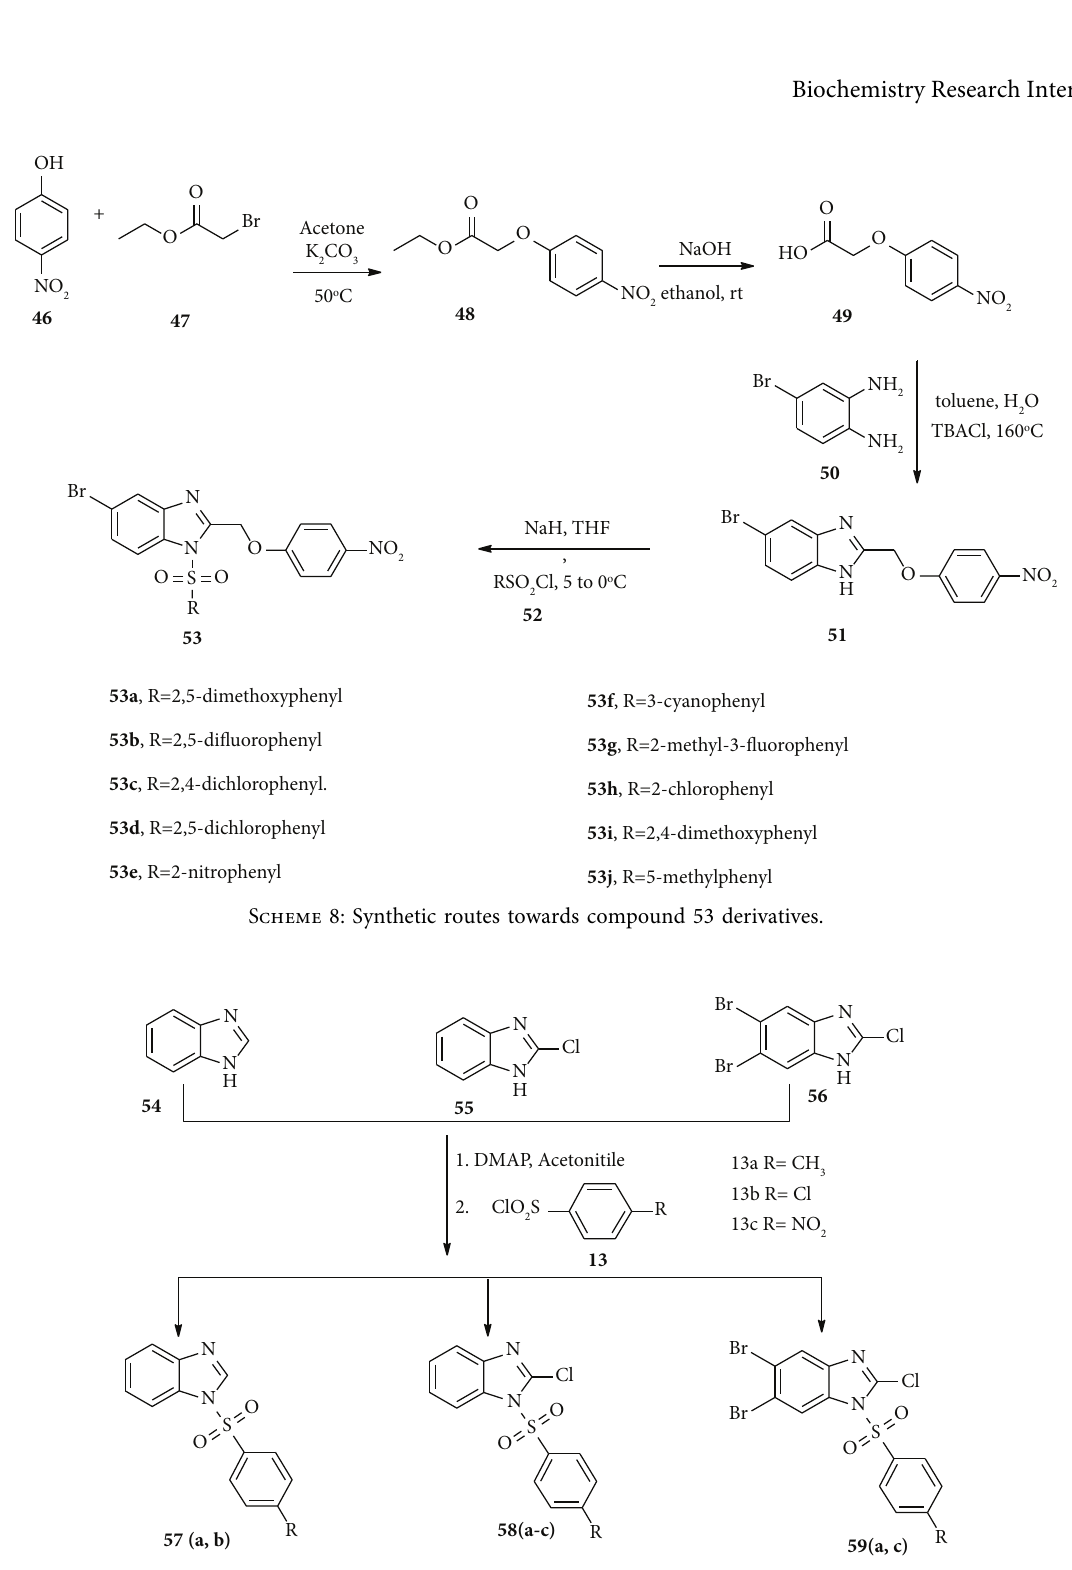
Scheme 9: Synthetic routes towards compounds